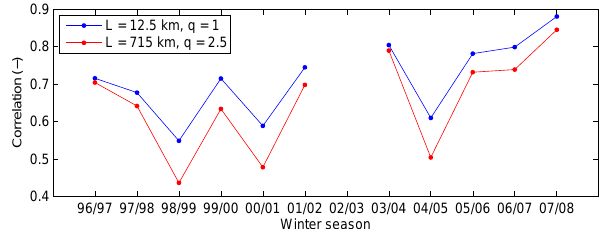
Fig. 7. Inter-annual variability of C in the study period for two se- lected (q,L) -pairs, calculated for seasonally detrended